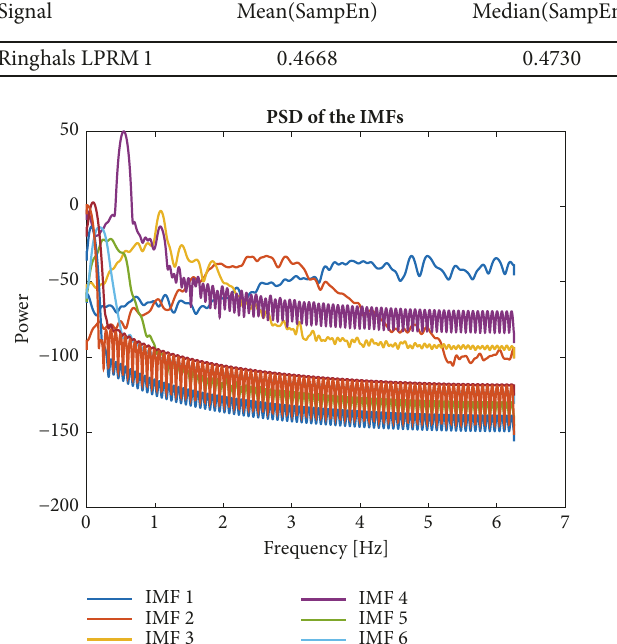
Table 4: Mean(SampEn), Median(SampEn), and std(Sampen) of the analyzed LPRM 1. Now the mean(IF) and std(IF) are included. Signal